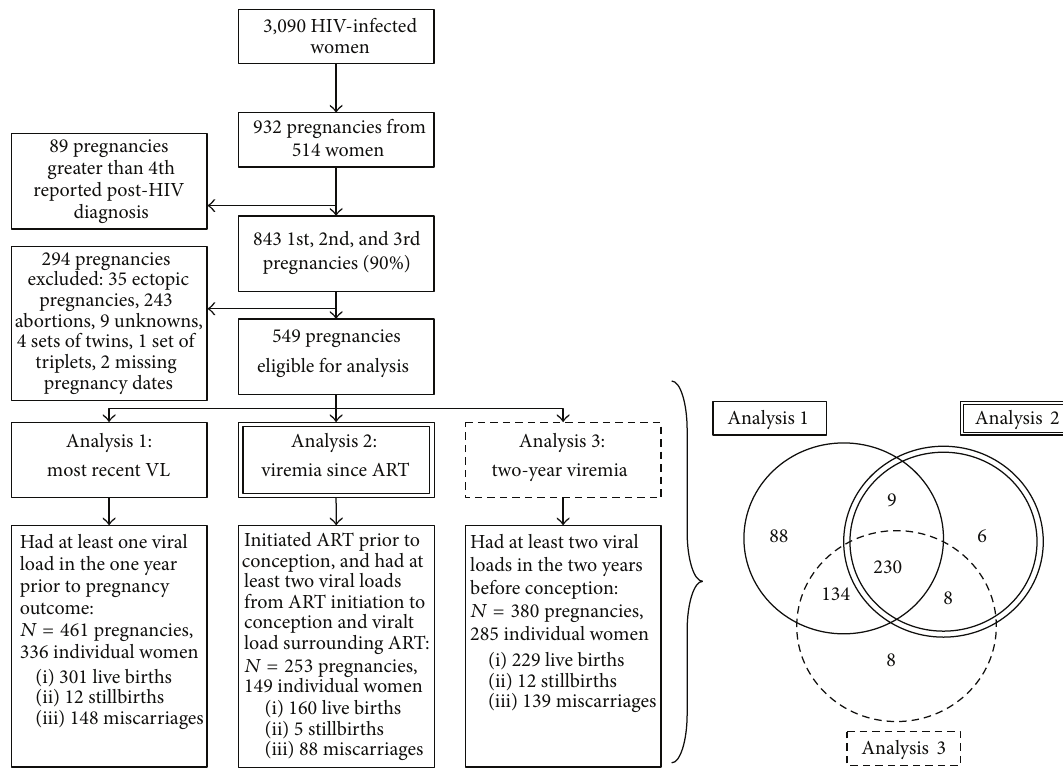
Figure 1: Flowchart and Venn diagram of women enrolled in the Women’s Interagency HIV Study (WIHS) since 1994, illustrating the inclusion criteria for pregnancies included in analyses 1, 2, and 3. The Venn diagram illustrates the overlap between the three analytic populations.